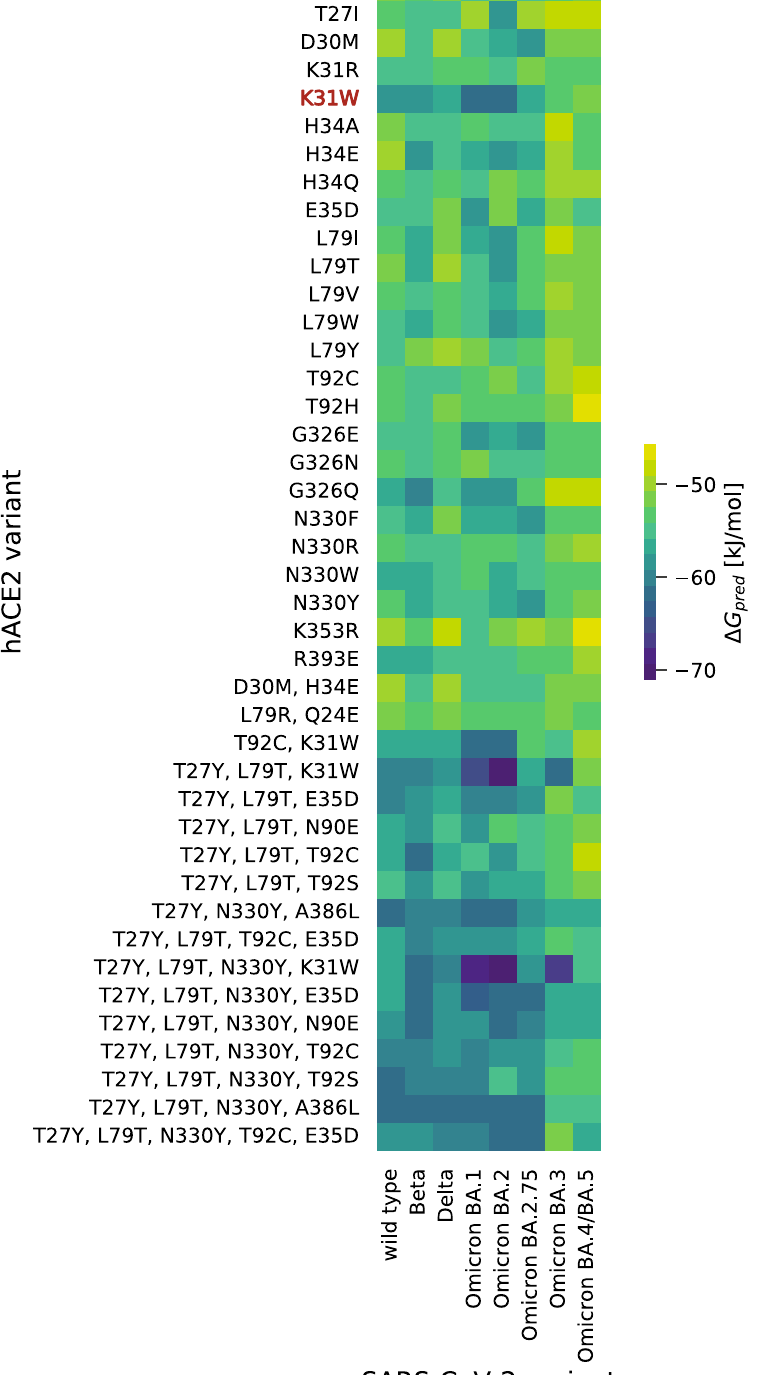
Figure 2. Gibbs free energy predictions of preselected hACE2 variants in combination with SARS-CoV-2 variants of concern. Van der Waals (vdw) and electrostatic (elec) energies from the MD simulation in combination with optimal fitted weights ( ω elec = 0.024, ω vdw = 0.765) from the training set resulted in predicted Gibbs free energies (Δ G pred